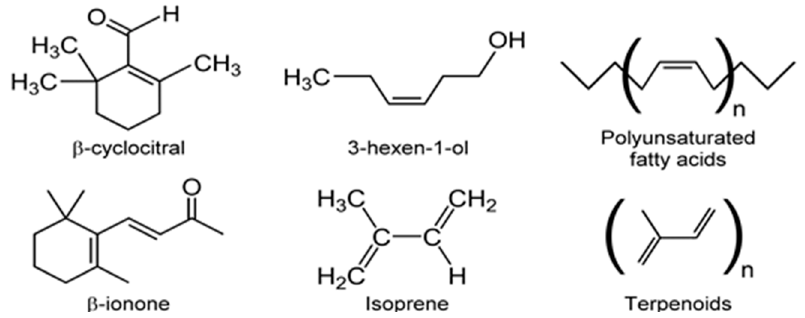
Figure 11. Chemical structures of a few prominent microalgal (‘other’) VOCs.